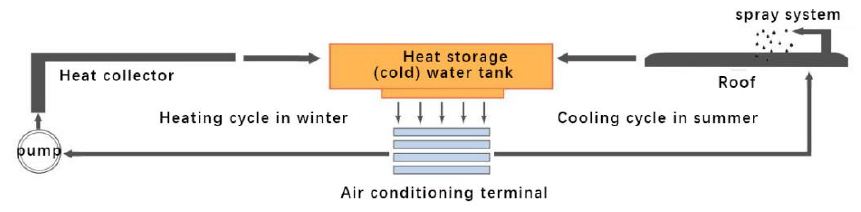
Figure 17. Working principle of heat collector in winter and summer.